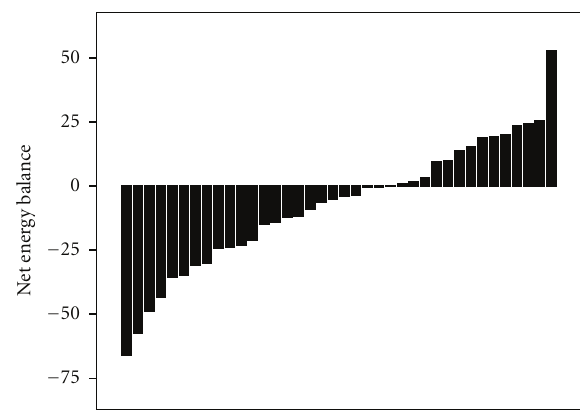
Figure 1: Individual variability in net energy balance after a prescribed volume of 12-week exercise ( N = 34) . A value below zero (i.e., “Responder”) indicates reduced body mass exceeding measured energy expenditure from the intervention. Values shown are for kcal in